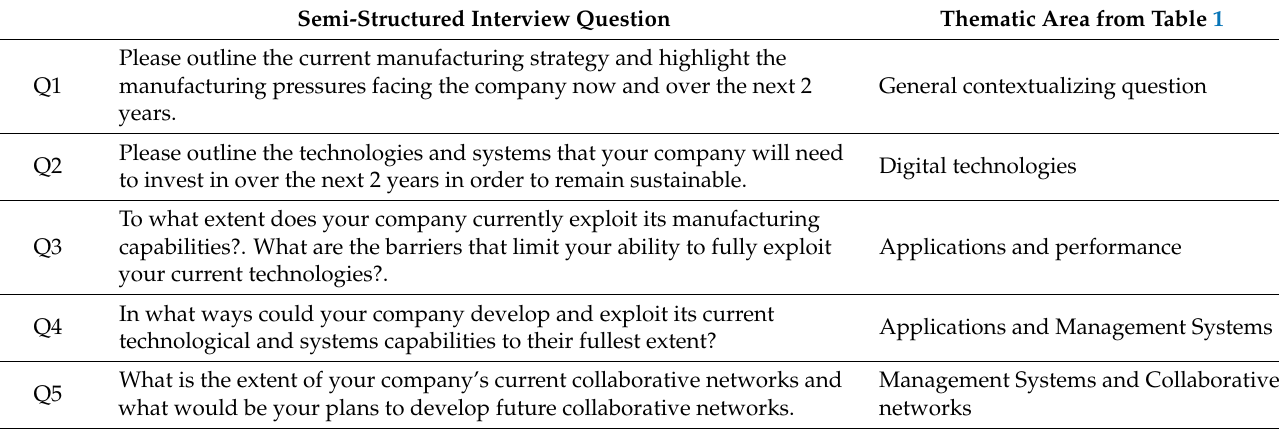
Table A2. Semi-Structured Interview